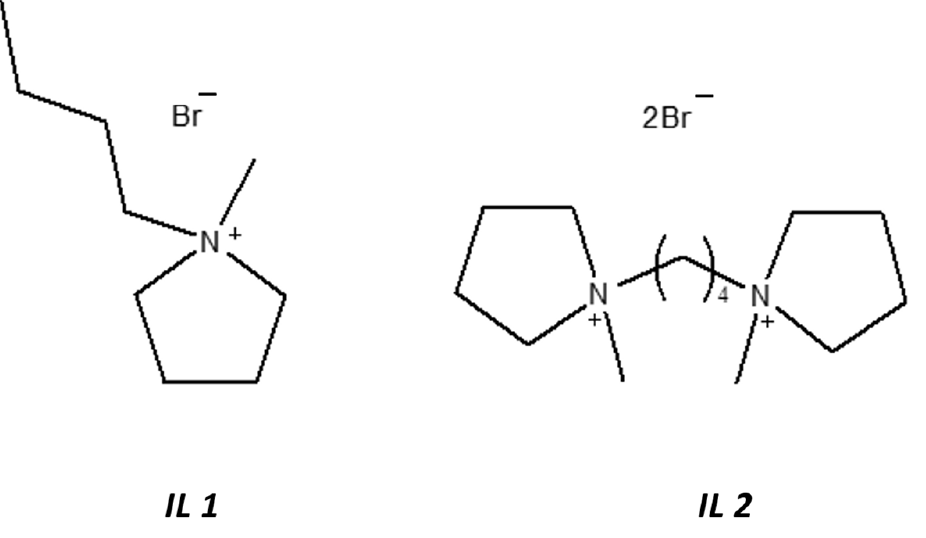
Figure 1. Chemical structures of the monocationic ( IL 1 ) and dicationic ( IL 2 ) pyrrolidinium-based